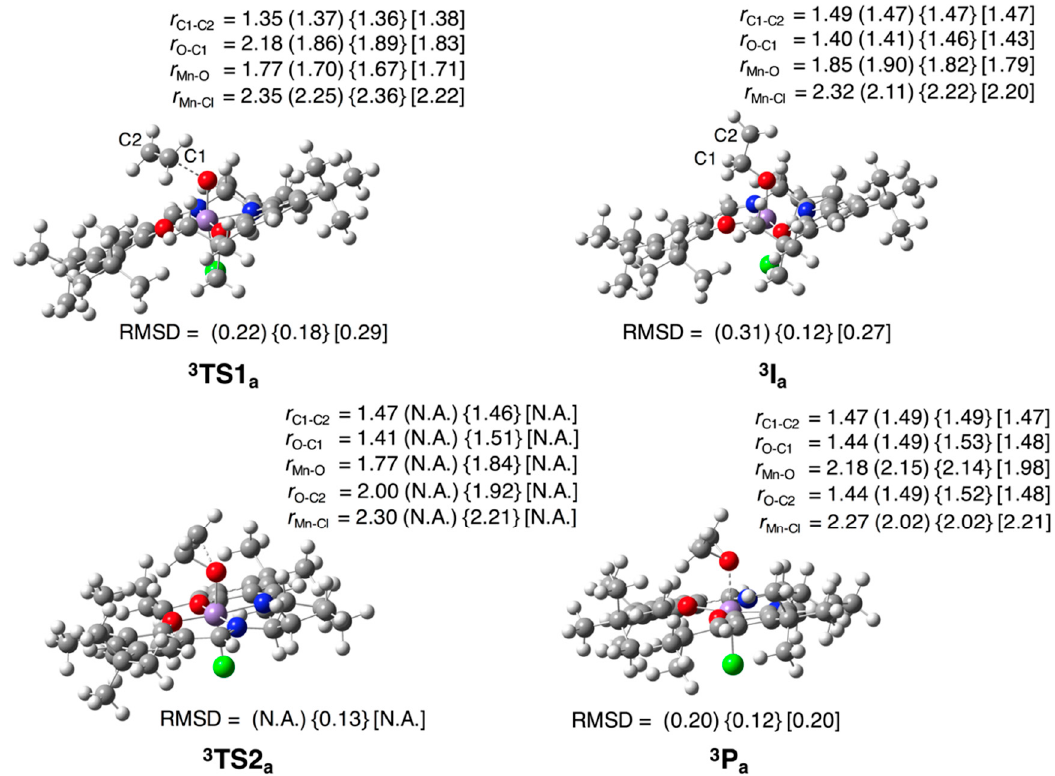
Figure 3. Selected optimized structural parameters of critical points in the epoxidation reaction of ethylene catalyzed by 3 [Cl–Mn V =O(salen)], with bond lengths (in Å) obtained at the UB3LYP/SVP, (UPM6), {UrPM6}, and [UPM7] levels of theory, and with heavy-atom root-mean-squared deviation (RMSD) values from the reference UB3LYP-optimized structures. N.A. represents not available (The optimization failed to converge).